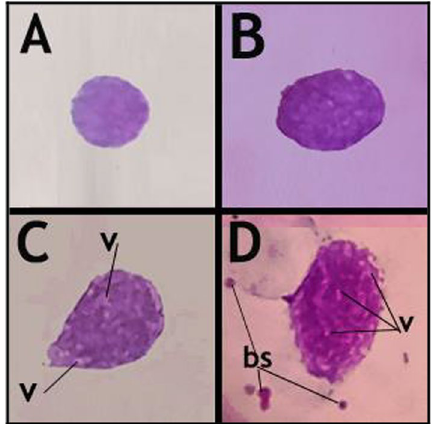
Fig. 11 Morphological changes in spherule cells ( x Control (normal larvae), B : F1 larvae (from irradiated male parent pupae with 100 Gy). v: vacuole, lm: lysed